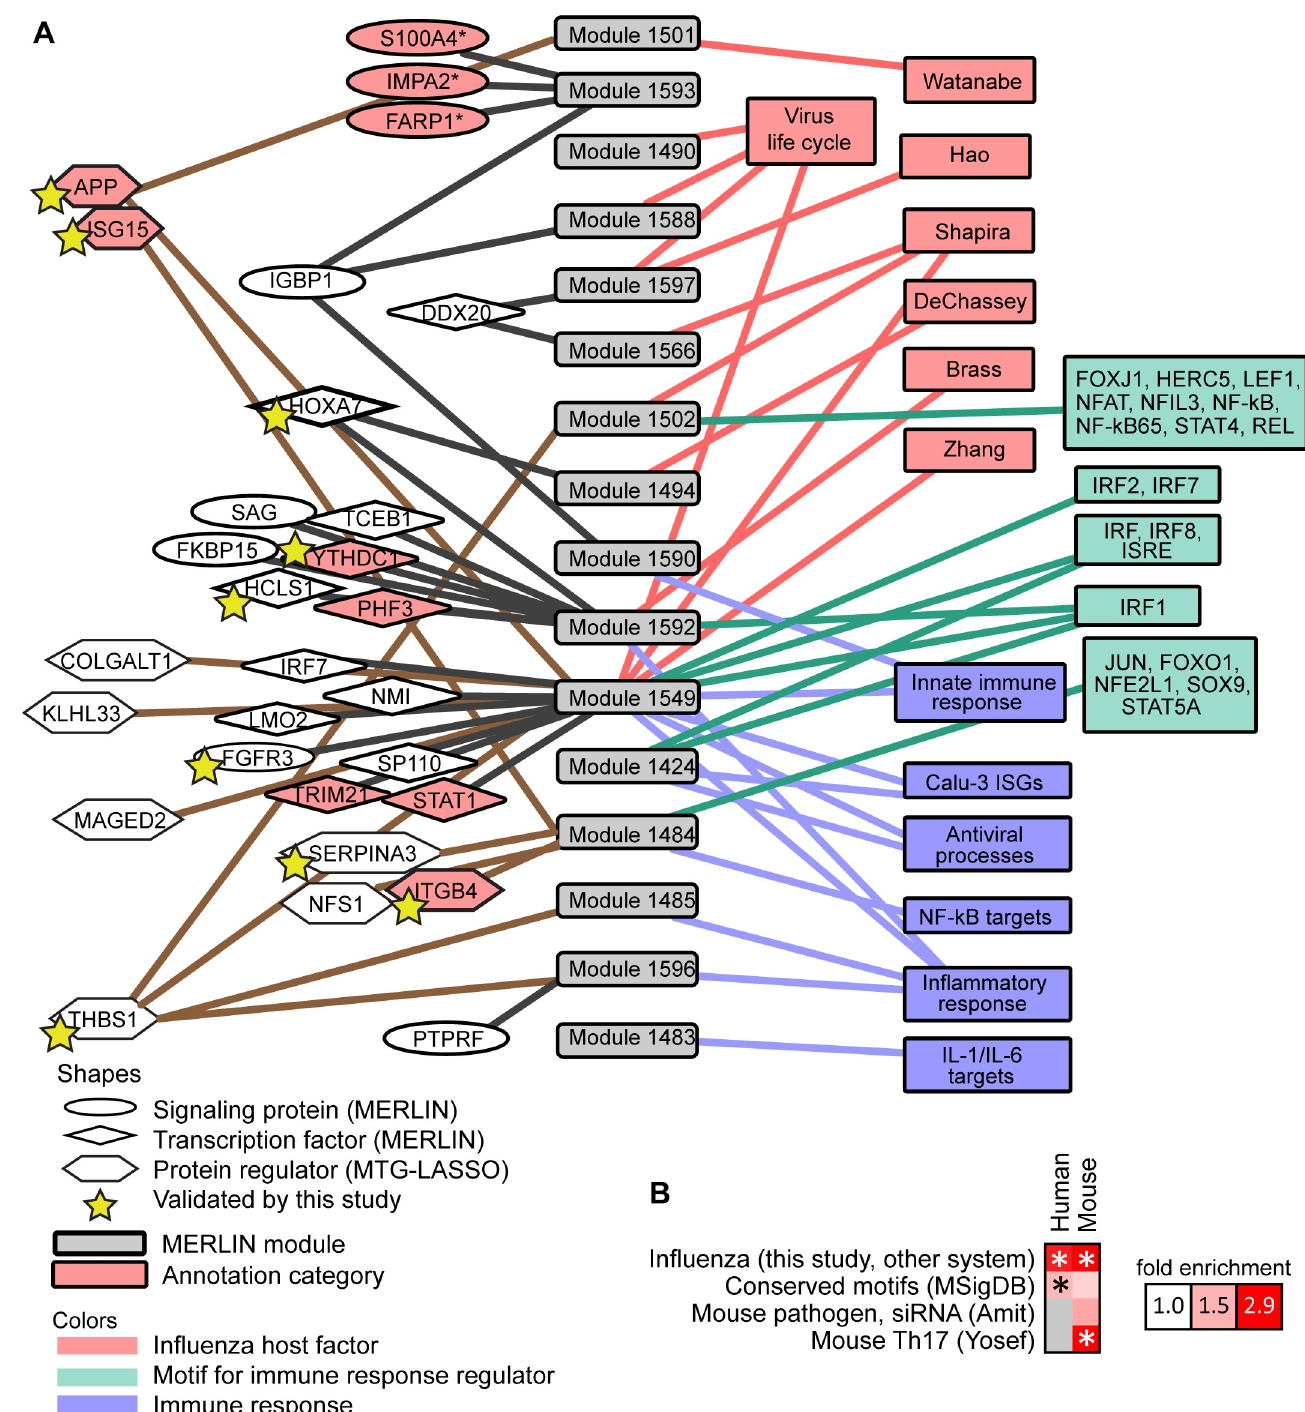
Fig 3. Overview of human influenza response modules and top predicted regulators. A. A selection of sixteen human modules (grey, center), with their top predicted regulators (shapes on left, connected to modules), and enriched gene sets relevant to immune response or viral life cycle (colored boxes, right). Modules were included in this figure if they were enriched for one of the following categories: (a) influenza host genes (pink) identified by RNAi, protein-protein interactions, expert curation (Zhang et al. 2009), or enrichment for other virus life cycle gene sets (from GO or KEGG); (b) motifs (green) for transcriptional regulators whose annotations indicate relevance to the innate immune response; (c) innate immune response gene sets (blue) from experimental results or manual curation. One module, Cluster 1593, is also included because its consensus regulator set (but not targets) was enriched for host proteins that are involved in the influenza life cycle from Watanabe et al (2014). Also shown are seventeen